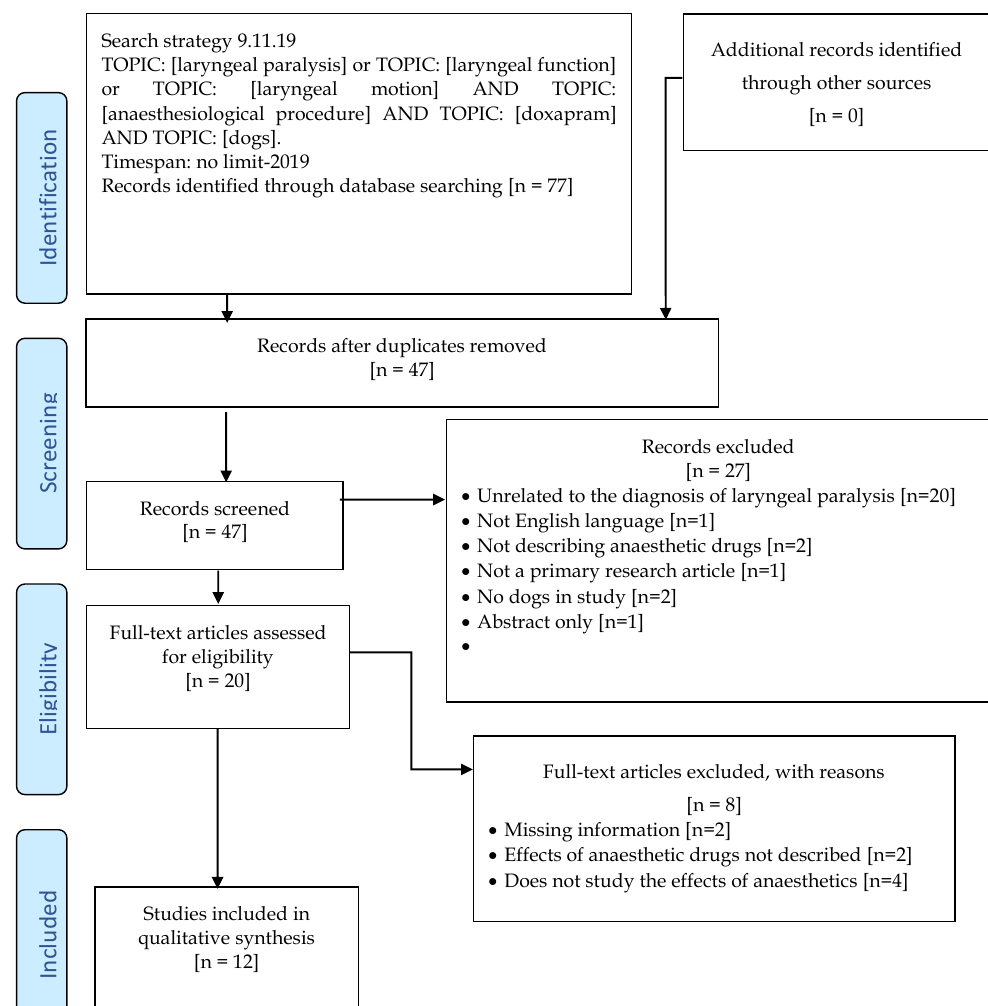
Figure 1. The review structure and search strategies evaluating the e ff ects of anaesthetic drugs on the laryngeal motion in dogs